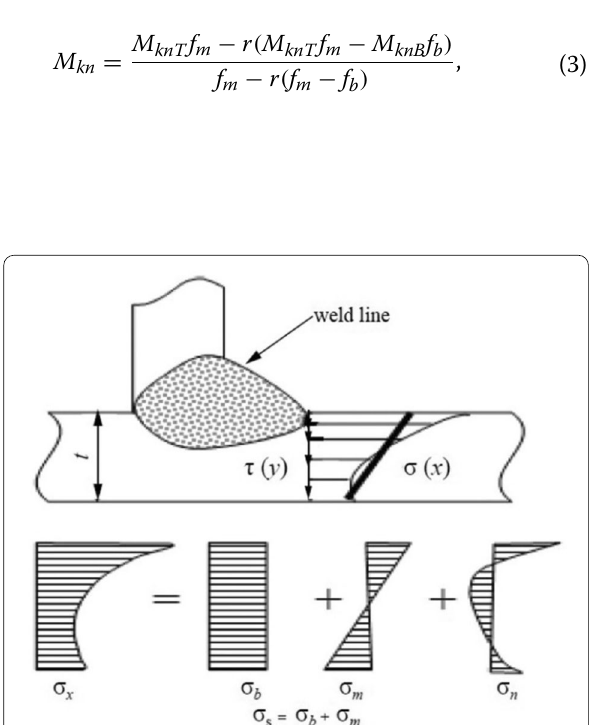
Figure 1 Structural stress and distribution at the weld